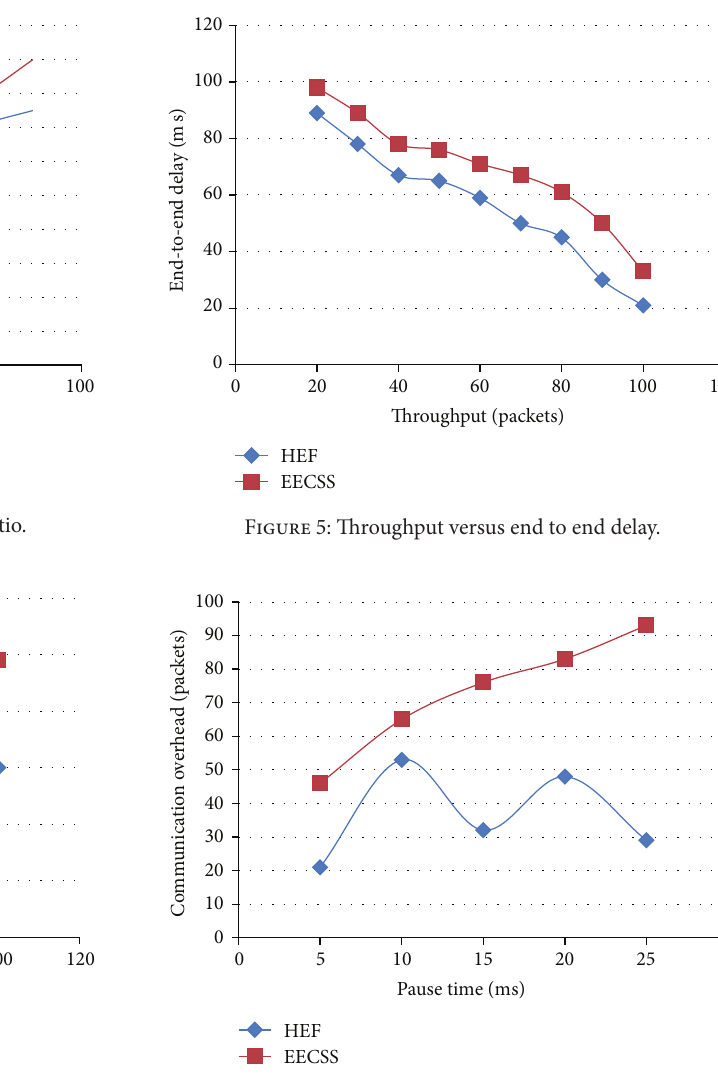
Figure 6: Pause time versus communication